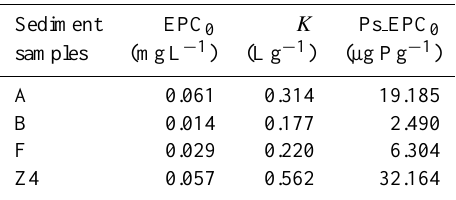
Table 3. Comparison of the buffering capacity of different sedi- ments to phosphate.